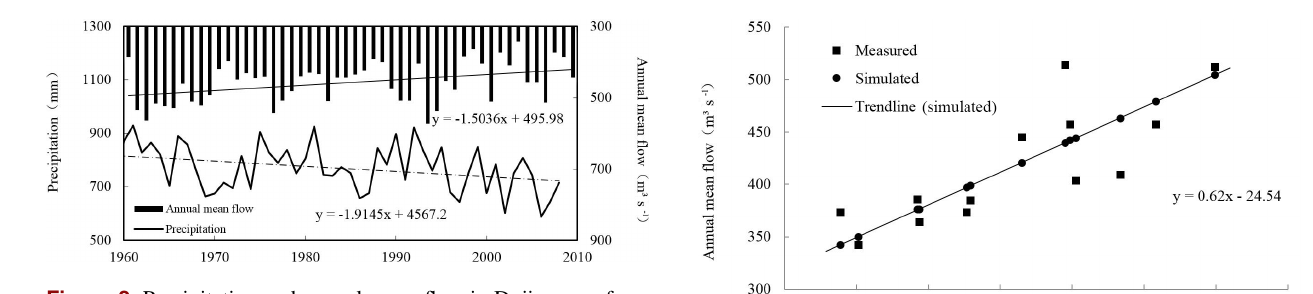
Figure 2. Precipitation and annual mean flow in Dujiangyan from 1959 to 2008.